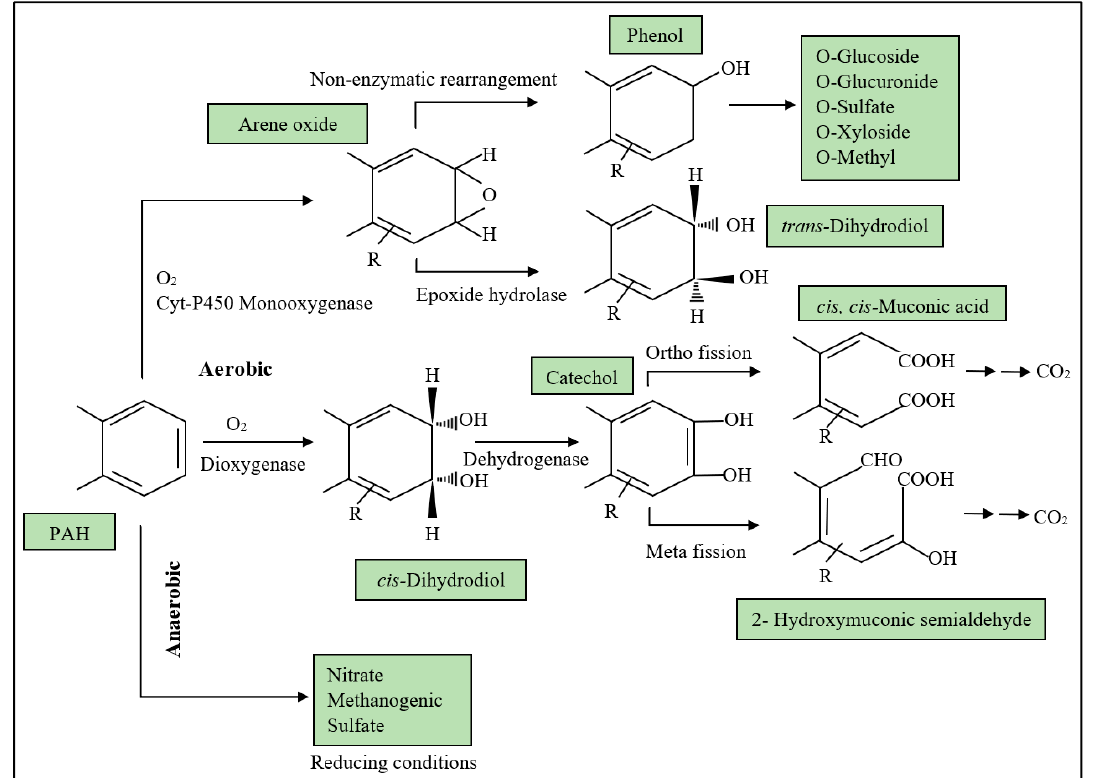
Figure 3. Proposed pathways for microbial catabolism of PAH (adapted [65]).